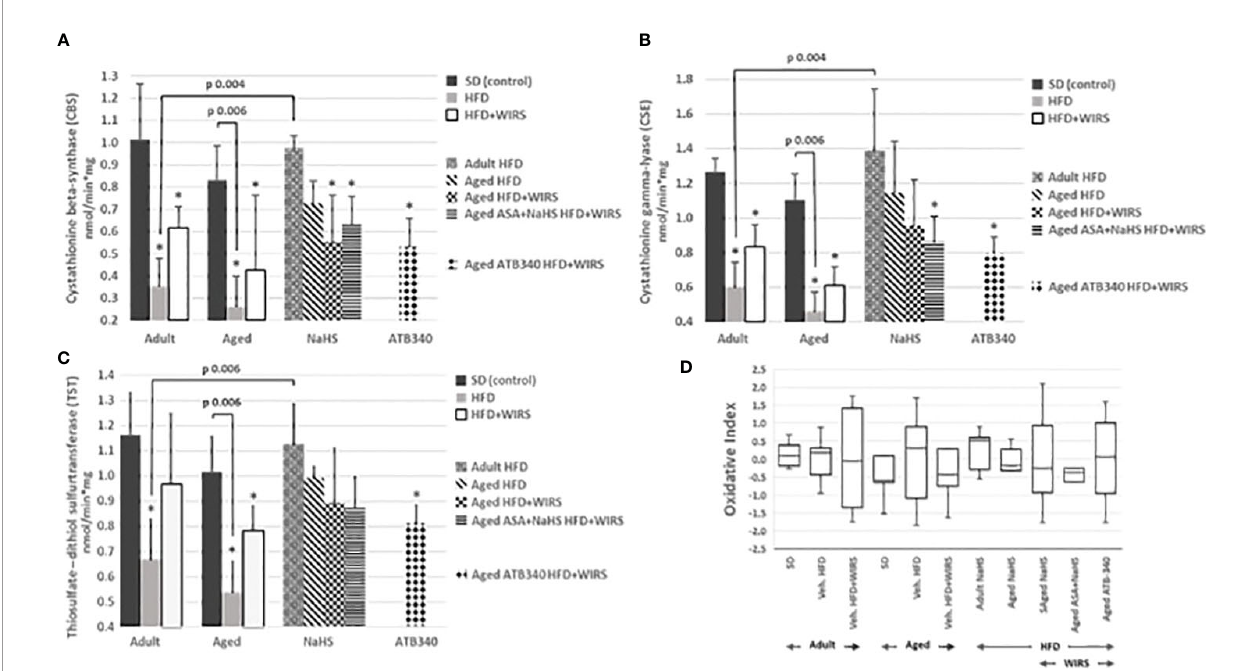
FIGURE 4 | Activities of Cystathionine- b -synthase (CBS) (A) , Cystathionine- g -lyase (CSE) (B) and Thiosulfate-dithiol sulfurtransferase (TST) (C) and changes of the oxidative index (D) in adult and aged rats (n = 5 – 6) fed with standard diet (SD) or high fructose diet (HFD) without and with H 2 S releasing molecule compounds therapy (NaHS, ATB-340) and induction of acute stress (WIRS). Columns with whiskers (A, B, C) show mean ± standard deviation (SD). Box plots (D) show the median, lower, and upper quartile ranges, and the minimum and maximum values of the oxidative index of all groups; *p < 0.05 versus